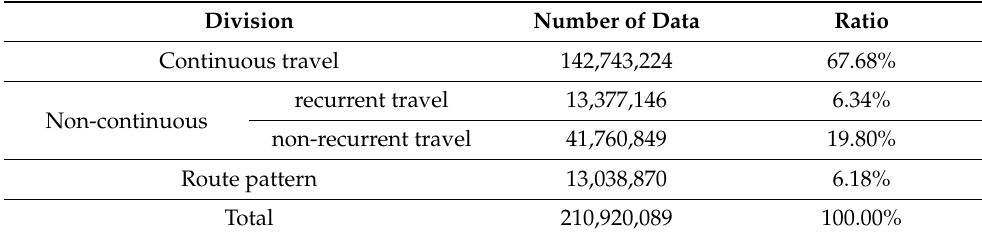
Table 4. Result of travel type classification (metropolitan area, as of April